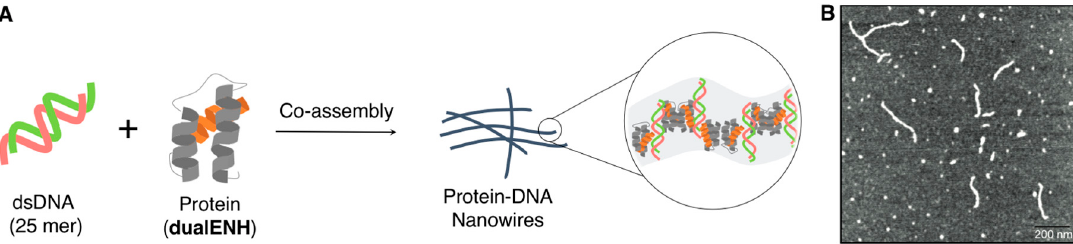
Figure 14. ( A ) Schematic representation of the formation of nanowires comprising a computationally designed protein/ dualENH and a short dsDNA. ( B ) A representative AFM image obtained after mixing dualENH with the dsDNA (25 bp). Adapted from [112]. Copyright 2014 Springer Nature.